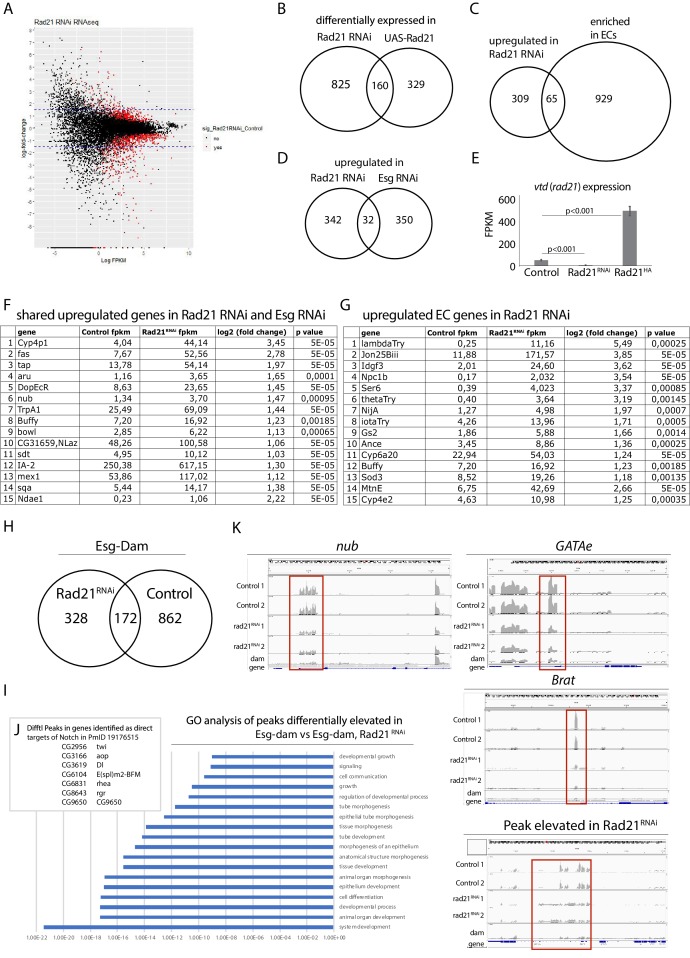
RNAseq and DamID analysis of ISCs after downregulating or overexpressing Rad21.(A) Transcriptomic analysis of ISCs expressing UAS-EYFP (Control) or Rad21RNAi or UAS-Rad21-HA. Scatter plot of gene expression regulation after Rad21 knock down. Red dots represent significant hits (false discovery rate q < 0.05). (B) Overlap between significantly differentially expressed genes found in Rad21 RNAi and UAS-Rad21-HA datasets, Fisher exact test (***p<0.001). (C) Overlap between genes upregulated in Rad21 RNAi dataset and EC-specific genes (Doupé et al., 2018), Fisher exact test (***p<0.001). (D) Overlap between genes upregulated in Rad21 RNAi and esg RNAi datasets, Fisher exact test (***p<0.001) (Korzelius et al., 2014). (E) Rad21 expression in Control, Rad21RNAi or UAS-Rad21-HA ISCs from (A). (F) Examples of EC genes upregulated after Rad21 knock down from C. (G) Examples of genes shared in Rad21 RNAi and esg RNAi datasets from D. (H) DamID analysis of ISCs expressing Esg-Dam (Control) and Esg-Dam/Rad21RNAi (Rad21 RNAi). Overlap between significant peaks found in Esg-Dam compared to Dam only and significant peaks in Esg-Dam/Rad21RNAi compared to Dam only. (I) GO analysis of peaks significantly elevated in Esg-Dam compared to Esg-Dam/Rad21 RNAi samples. (J) Differential peaks as direct targets of Notch from H. (K) Differential occupancy of nub, GATAe and Brat loci by Esg-Dam or Esg-Dam after Rad21 knock down. Dam only serves as control. Lower panel shows peaks elevated after Rad21 knock down.Figure 6—source data 1.Transcriptomic analysis of ISCs expressing UAS-EYFP (Control) or Rad21RNAi or UAS-Rad21-HA.Raw data; overlaps of genes sets between Rad21 RNAi and UAS-Rad21-HA; upregulated genes in Rad21 RNAi and Esg RNAi (Korzelius et al., 2014); upregulated genes in Rad21 RNAi and EC-specific genes (Doupé et al., 2018).Figure 6—source data 2.DamID analysis of ISCs expressing Esg-Dam in a wild-type (control) or Rad21 deficient (Rad21-) background.Methylated DNA enrichment was measured relative to samples from dam-expressing ISCs (two independent samples for each condition; see Materials and methods for details). Peaks that pass IDR (irreproducible discovery rate) test in esg-dam (control) and esg-dam (Rad21-) samples were called and are shown in separate worksheets (‘idr_esg-dam (Rad21-) Peaks’ and ‘idr_esg-dam (Control) Peaks’). Merged peaks with chromosomal location are shown in the worksheet labeled ‘merged_esg-dam (ctrl and Rad21-)’, and peaks enriched in Control and Rad21 RNAi conditions are shown with gene annotations in the other two worksheets.